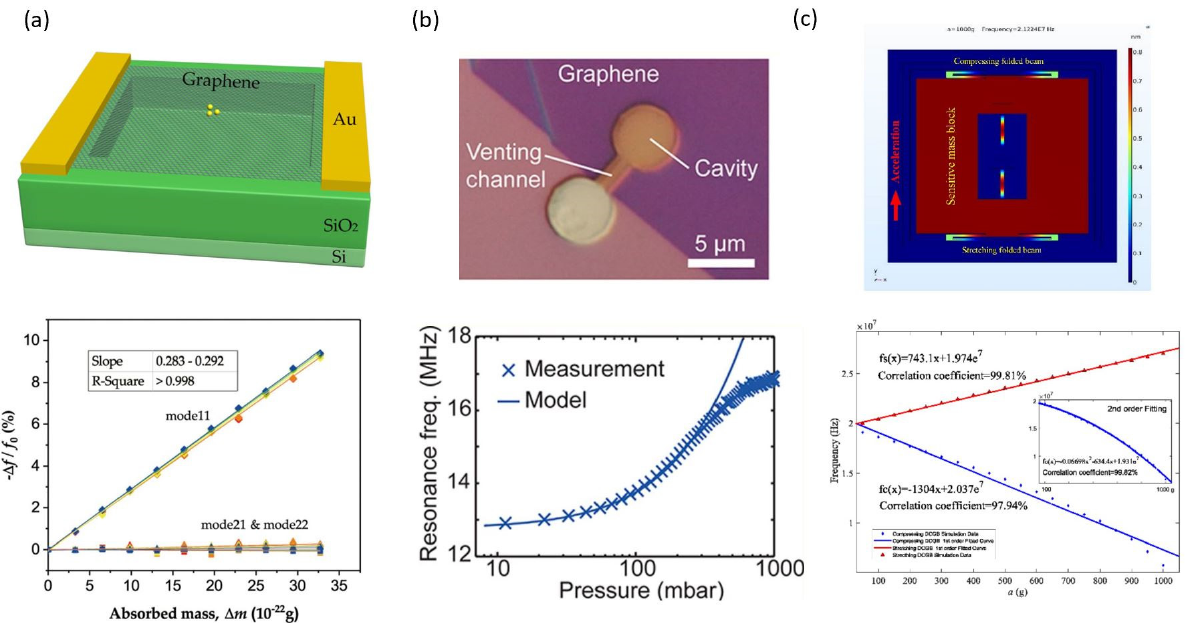
Figure 6. Graphene resonant sensors. ( a ) A graphene resonant mass sensor with simulation results [78]. ( b ) A graphene resonant pressure sensor with measurement results [34]. ( c ) A graphene resonant accelerator with simulation results [83].